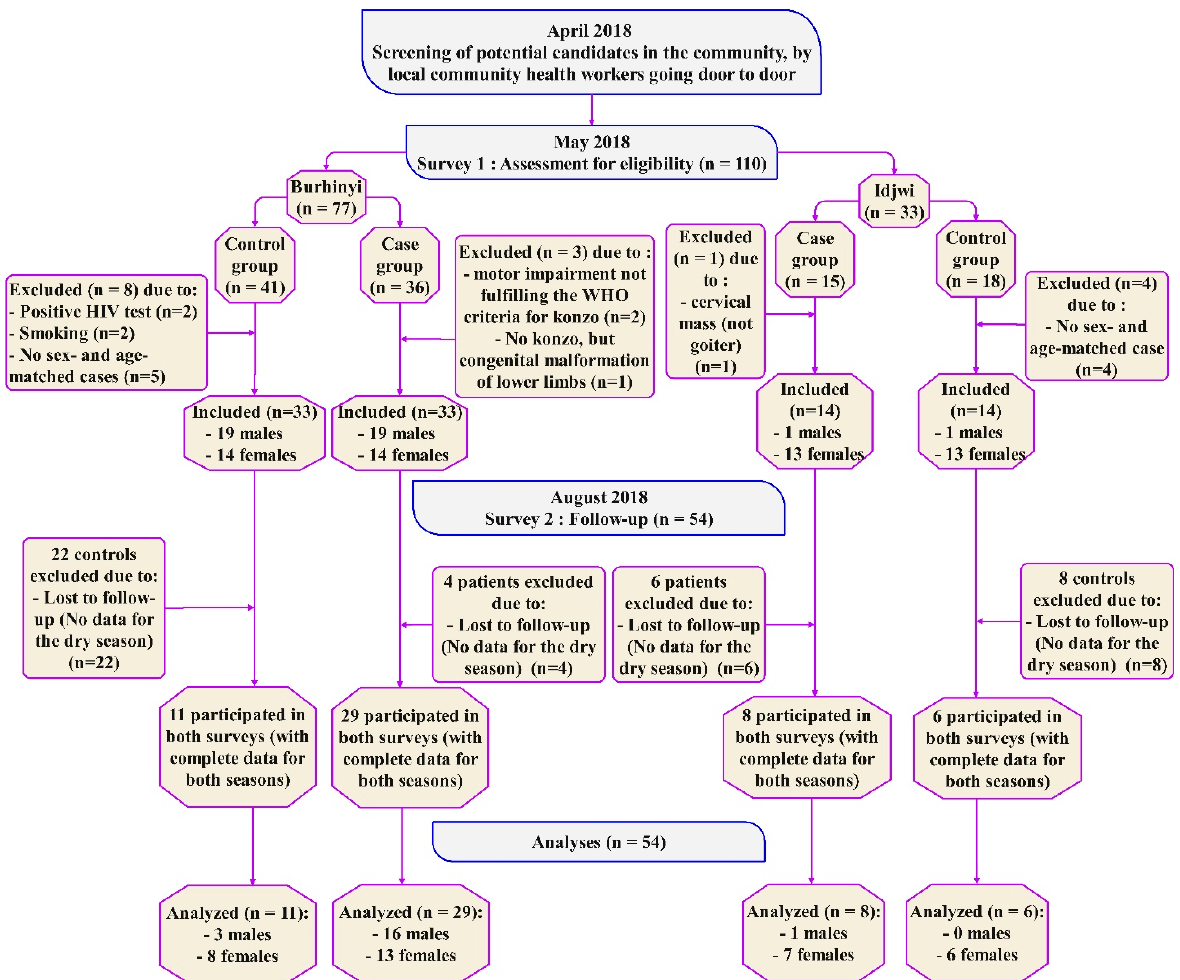
Figure 2. Flowchart of the study participants recruitment.